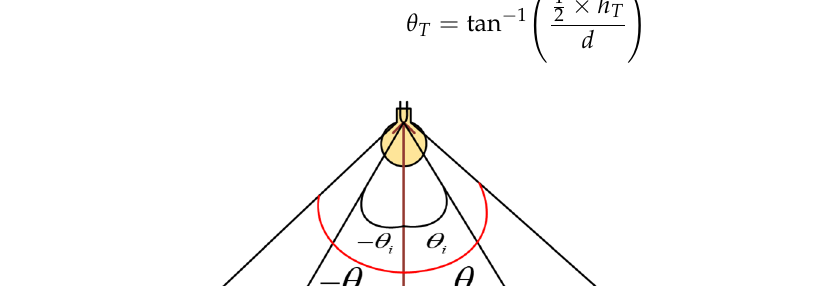
In Equation (2), L represents the length of the antenna.